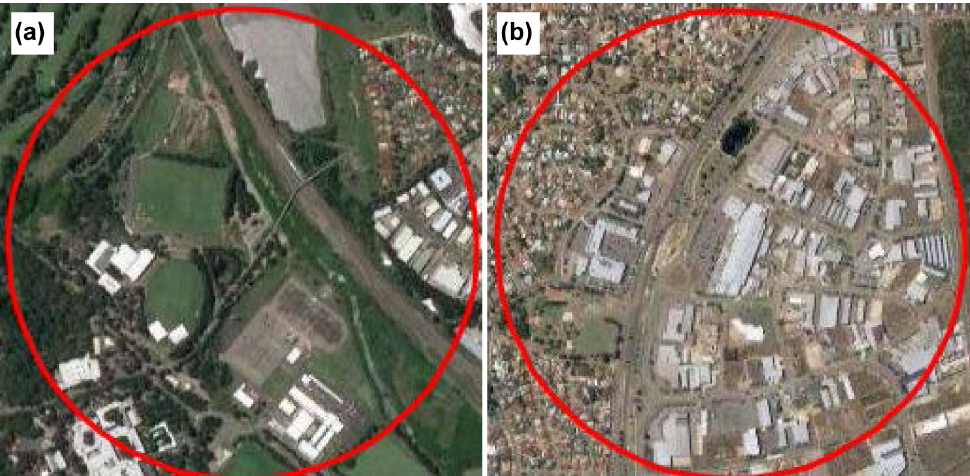
Fig. 1. Location of the wind-monitoring site at the University of Newcastle (a), and Bunnings, Port Kennedy (b), with a 500m radius indicated (Google Maps,